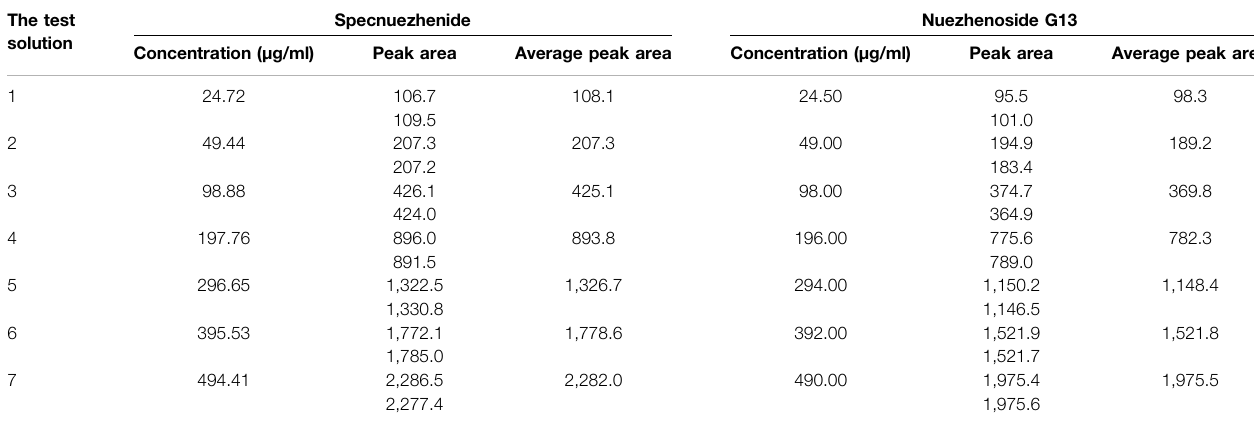
TABLE 1 | The linear test results of specnuezhenide and Nuezhenoside G13. The test Specnuezhenide Nuezhenoside solution